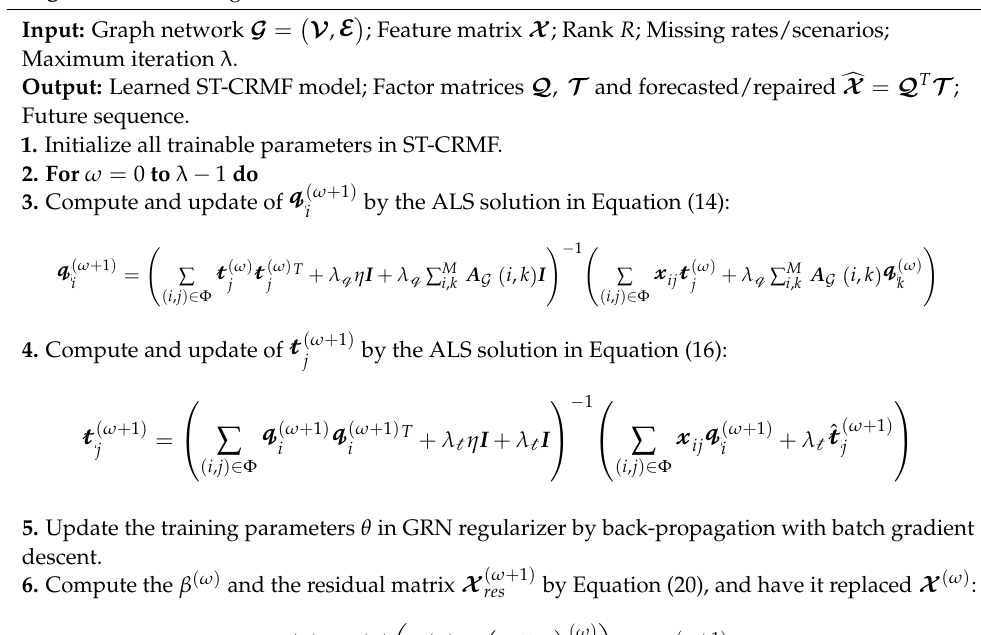
Figure 1. Illustration of multivariate time series forecasting (each 𝔁 (cid:3047) is a frame of traffic data at time step 𝑡 ).